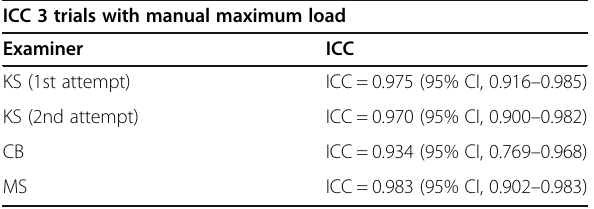
Table 3 Intraclass correlation coefficient of 3 trials with manual Table 1 Intraclass correlation coefficient of 5 trials with 2 Nm